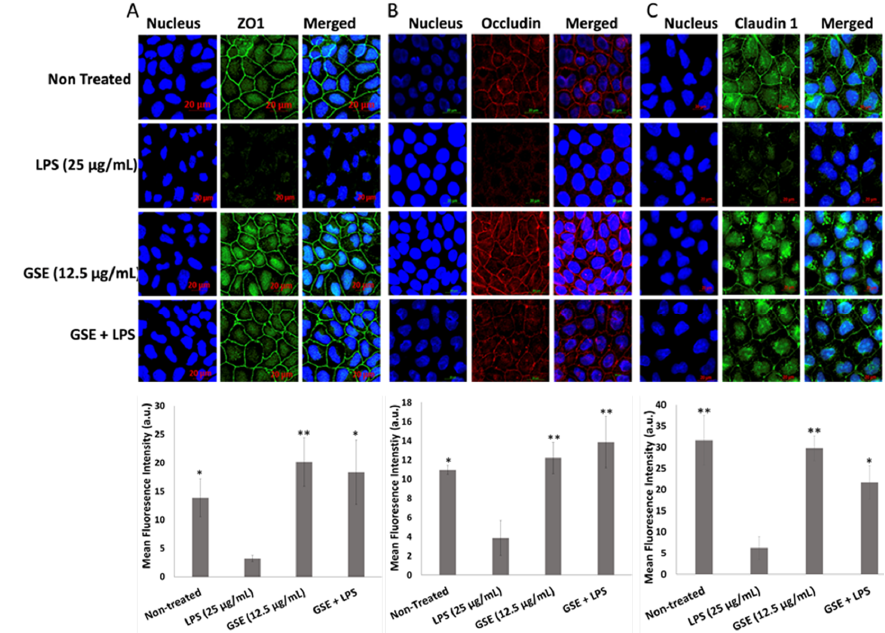
Figure 5. Immunolocalization (top) and its relative fluorescence intensity (bottom) of tight junction proteins. ( A ) Zona occludens 1 (ZO1), ( B ) occludin, and ( C ) claudin 1 protein expression was significantly reduced in LPS-treated cells compared to untreated control while GSE treatment significantly restored tight junction protein expression. Error bars indicate ± S.D. ( n = 3). * and ** indicate the data were significantly di ff erent relative to LPS-treated cells with p ≤ 0.05 and p ≤ 0.01 respectively using Tukey’s